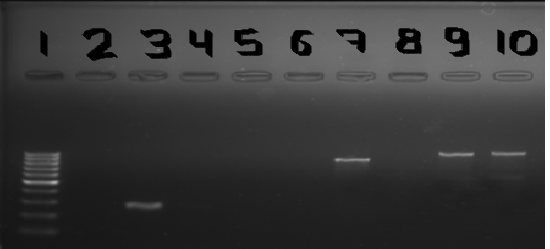
Figure 1. DNA gel electrophoresis showing the mecA and virulence tsst-1 and the ClfA genes of S. aureus . Lane 1 represents a 100 bp DNA ladder; Lane 2 shows the negative control of tsst-1 ; Lane 3 shows an isolate expressing the 271 bp tsst-1 gene; Lanes 4 and 5 show two isolates that are tsst-1 - negative.; Lane 6 shows the negative control of the mecA gene; Lane 7 shows an isolate expressing the amplified 855 bp mecA gene; Lane 8 shows the negative control of the Clf-A ; and Lanes 9 and 10 show the amplified 980 bp ClfA gene from two isolates.